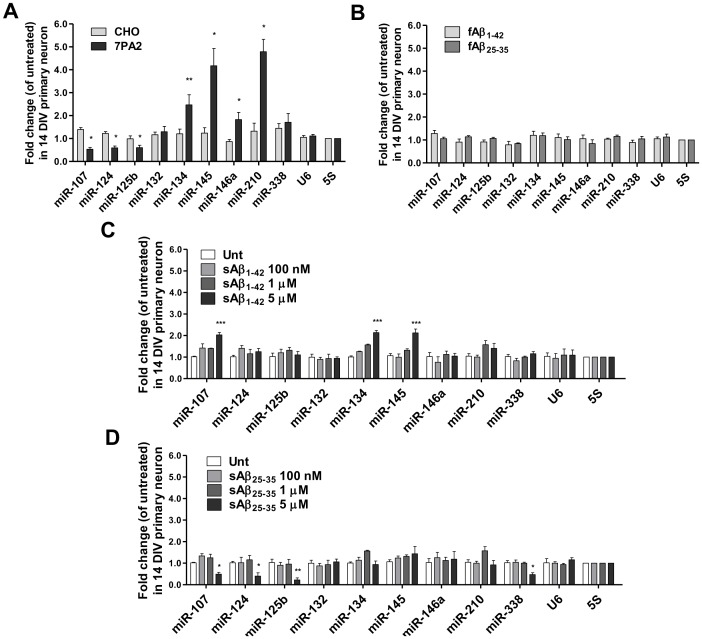
Differential regulation of miRNA expressions in primary cortical neurons by sAβ and fAβ.The 14 DIV rat primary neurons were either untreated or treated for 24(A) CHO or 7PA2 CM (n = 6); (B) 5 µM fAβ25–35 or fAβ1–42 (n = 4); (C) 100 nM, 1 µM or 5 µM synthetic sAβ1–42 (n = 3); (D) 100 nM, 1 µM or 5 µM synthetic sAβ25–35 (n = 3). qRT-PCR data were normalized to 5S rRNA. Two-tailed Student's t-test was used for statistical comparison for panels A and B. Two-way ANOVA followed by bonferroni post-test was used for panels C and D: *p<0.05, **p<0.01, ***p<0.001.